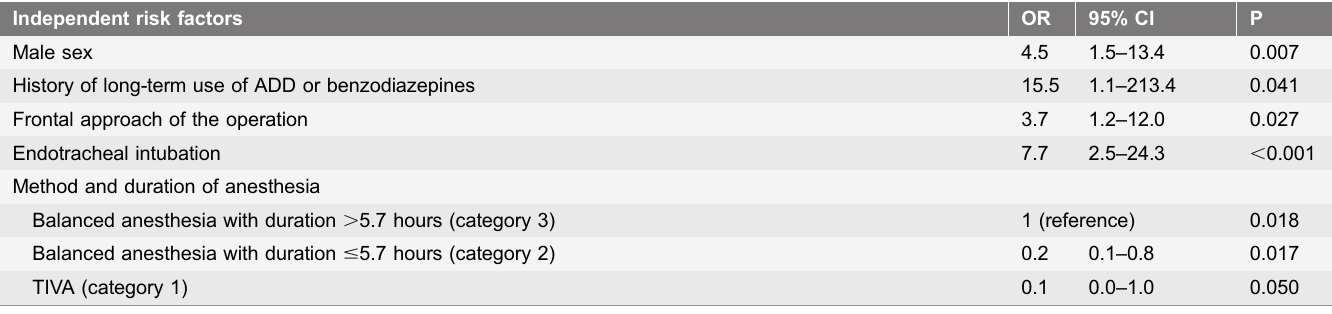
Table 4. Independent predictors for